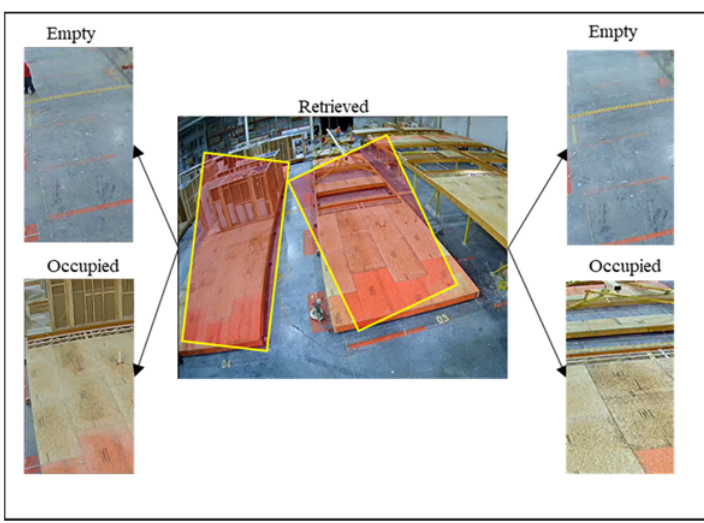
Figure 12. Four ground truth images annotated for two stations.